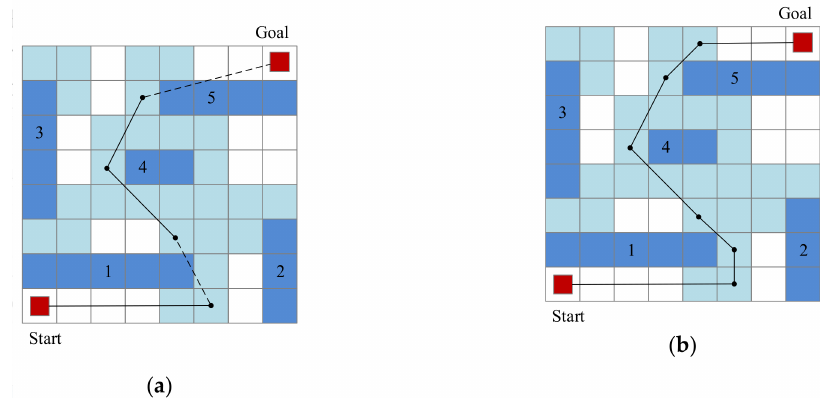
Figure 13. Modifying two infeasible cells for the same obstacle. ( a ) An infeasible solution; ( b ) detour path generated to maintain